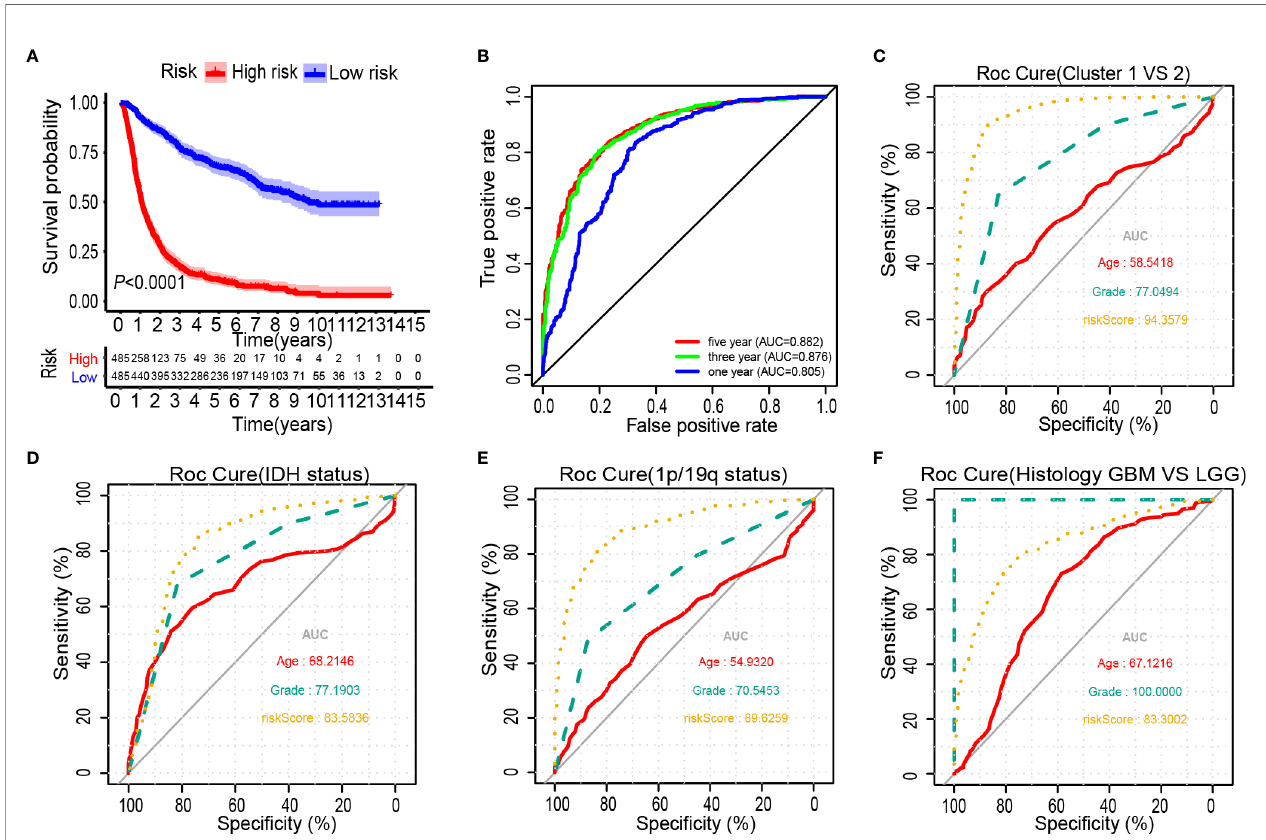
FIGURE 4 | Prognostic signi fi cance of the 25-gene signature derived risk scores in CGGA cohort. (A) Kaplan-Meier analysis of CGGA gliomas patients was strati fi ed by median risk. (B – F) High-risk scores are associated with general poor survival of gliomas. ROC curves showed the predictive ef fi ciency of the risk signature, overall survival (B) , Cluster 1/2 subgroups (C) , IDH status (D) , 1p/19q status (E) , and Histology (F)